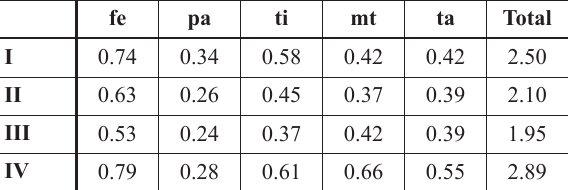
Figs 3D-F, 12H-J, 14; Appendix